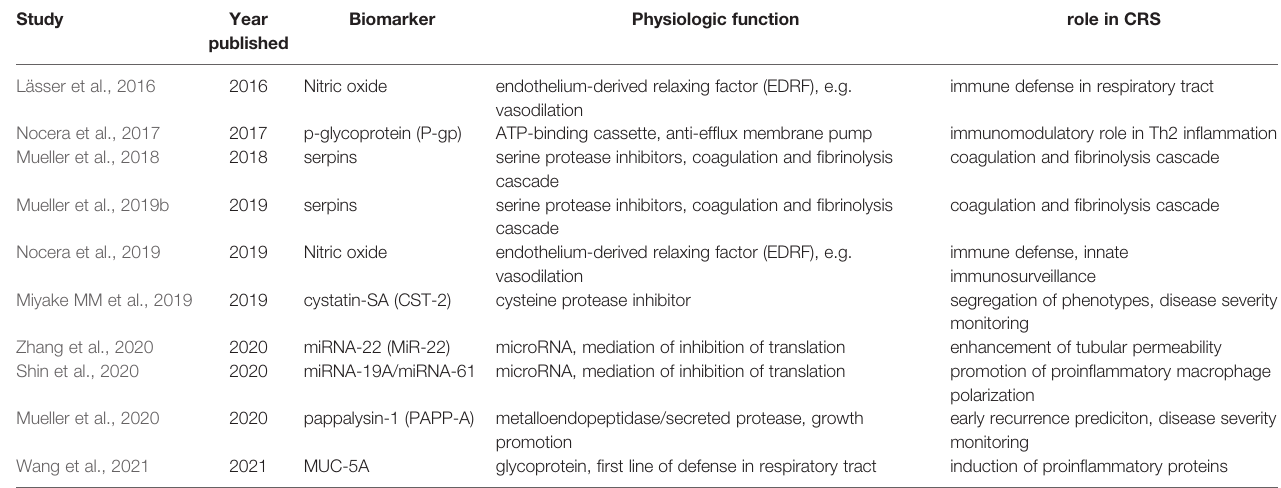
TABLE 1 | Summary of all exosomal biomarkers including their physiological function and their supposed role in